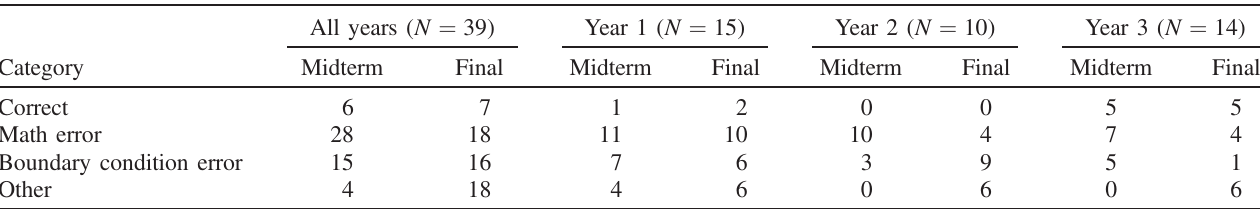
TABLE II. Student responses on midterm and final exams. Students can be listed in multiple